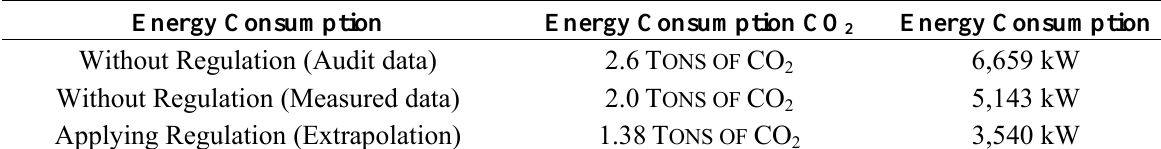
Table 12. Annual